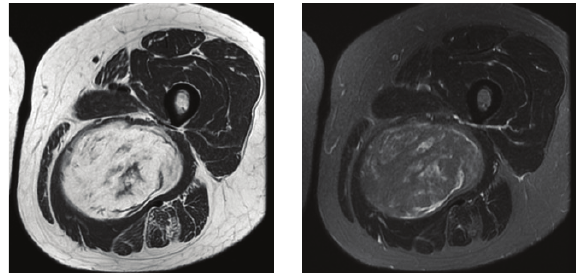
Figure 3: Axial T1 and T2 MRIs showing intralesional stranding in a fatty tumor. Final pathological review confirmed a diagnosis of low- grade liposarcoma.